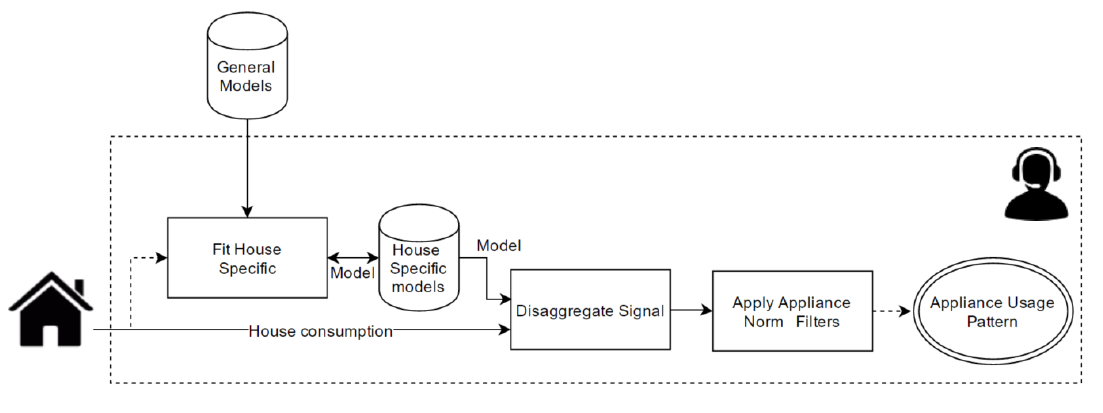
Figure 4. The disaggregation process.